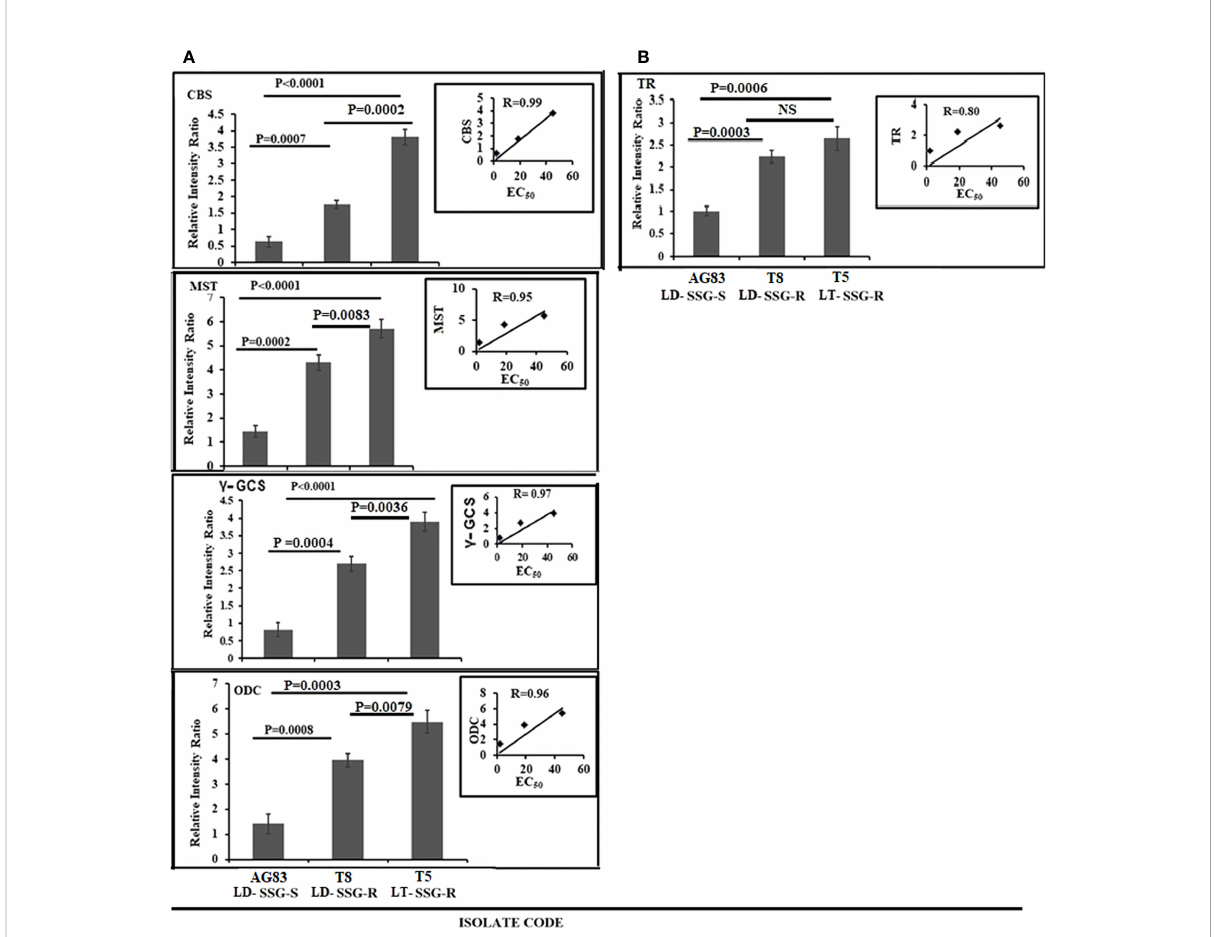
FIGURE 3 Graphical representation of the densitometric data. (A) Expression levels of thiol-metabolizing enzymes CBS, MST, g -GCS, and ODC were expressed as a ratio of CBS, MST, g -GCS, and ODC mRNA levels to GAPDH mRNA level, respectively. Data were expressed as the mean ± SD of three independent experiments. Each scatter plot in the inset represents the correlation between the EC 50 of the isolates against sodium stibogluconate and the respective gene expressions. (B) The expression level of another thiol-metabolizing enzyme (TR) was expressed as a ratio of TR mRNA level to GAPDH mRNA level. Data were expressed as the mean ± SD of three independent experiments. Each scatter plot in the inset represents the correlation between the EC 50 of the isolates against sodium stibogluconate and the respective gene expression. NS, Non-signi fi cant.